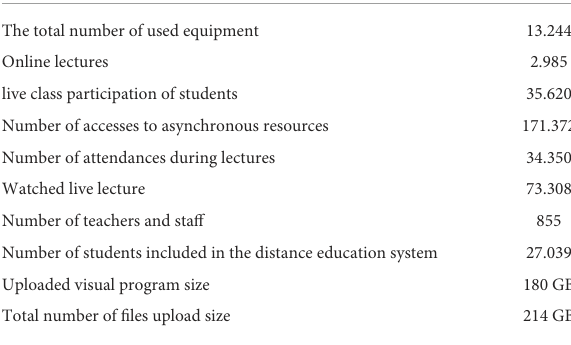
TABLE 1 The distance education learning statistics performed in the 2019–2020 spring pandemic.